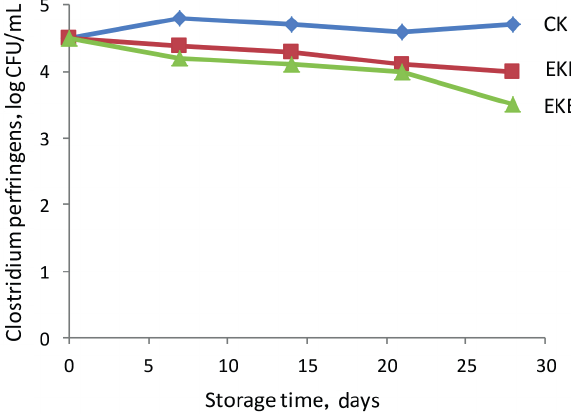
Figure 3 Dependence of Clostridium perfringens concentration in kashk samples on storage time . CK: control kashk, EKI: experimental kashk with MIC (0.211 mg/mL of caper extract), and EKB: experimental kashk with MBC (0.350 mg/mL of caper